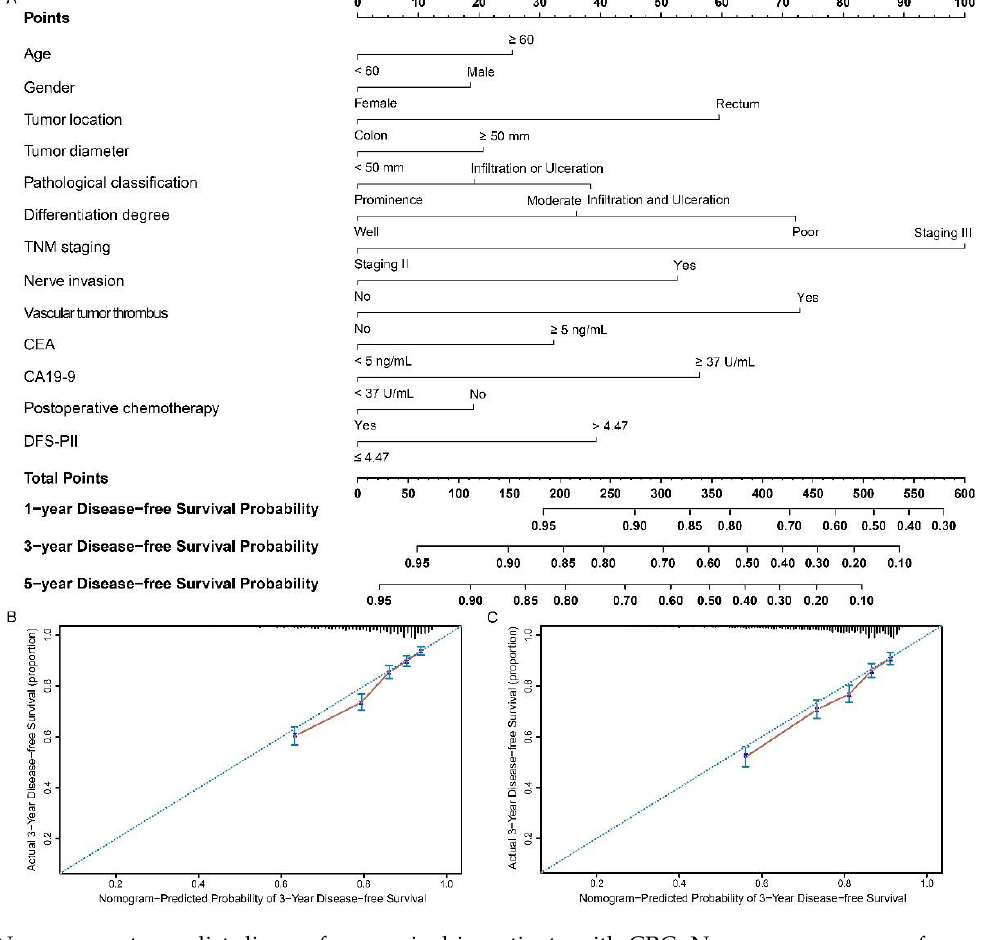
Figure 5. Nomograms to predict disease-free survival in patients with CRC. Nomograms were performed by using clinicopathological characteristics and DFS-PII to predict disease-free survival ( A ) and calibration curves of the nomogram to predict disease-free survival at 3 years in the training cohort ( B ) and the validation cohort ( C ). Nomograms map the predicted probabilities onto points on a scale from 0 to 100 and can be interpreted by accumulating the points that correspond to the predicted probability, which is indicated at the top of scale. The total points were converted to predict 1-, 3- and 5- year probabilities of death and recurrence or metastasis for patients with CRC.